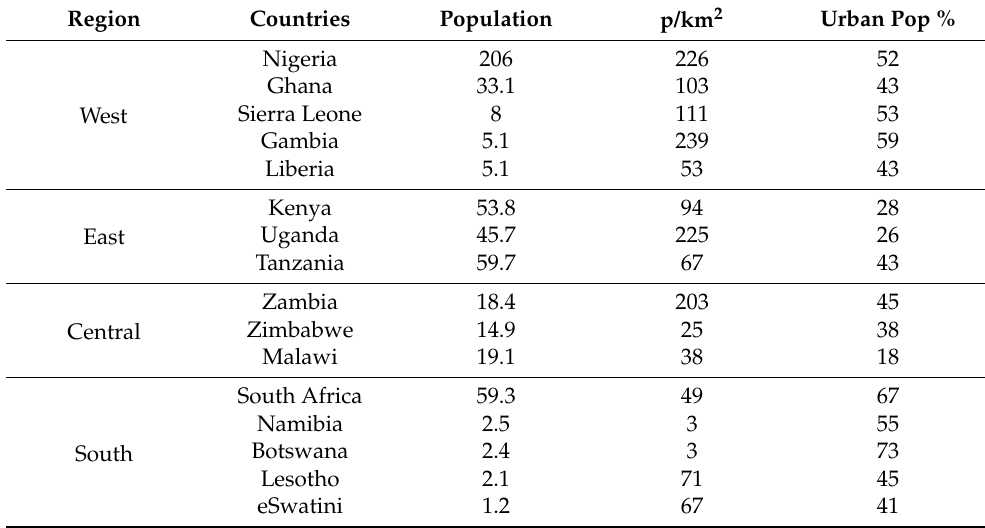
Table 1. Anglophone countries in sub-Saharan Africa (SSA, by region). Source: